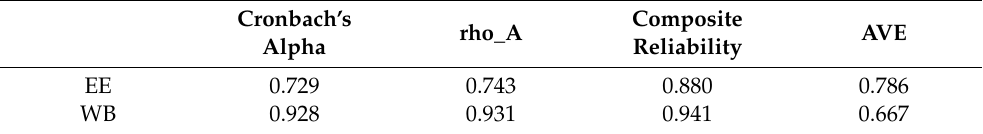
Table 2. Reliability and validity of the applied